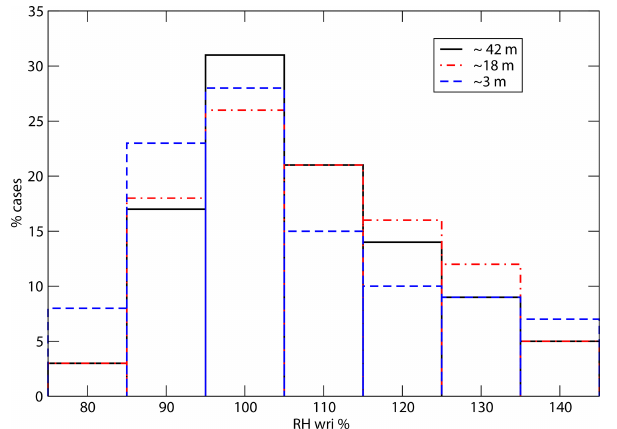
Figure 5. Frequency distribution of RHi observed at the three levels on the tower from 2018 to 2020.